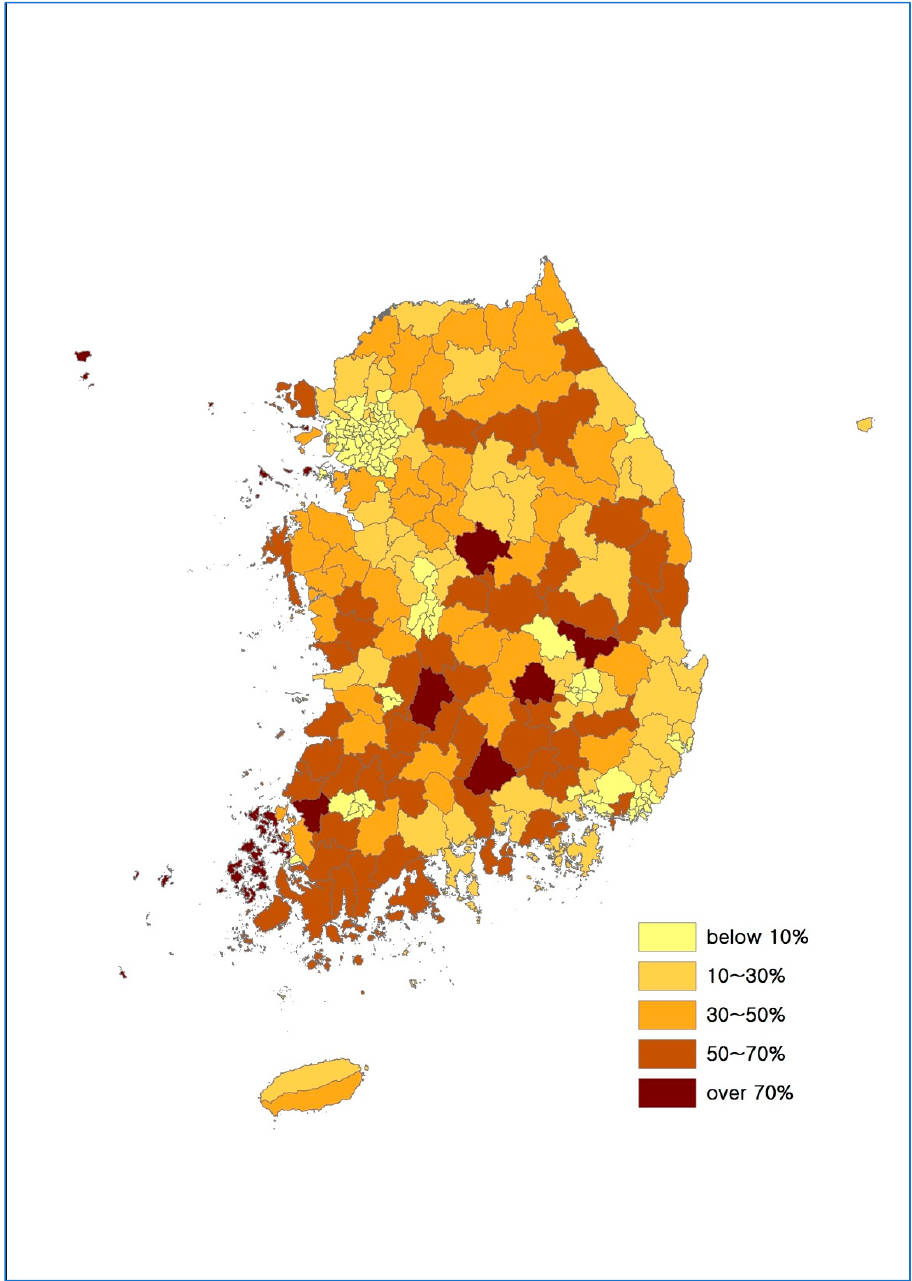
Figure 6. Map for Accessibility to Foods of Korea, Case 1.